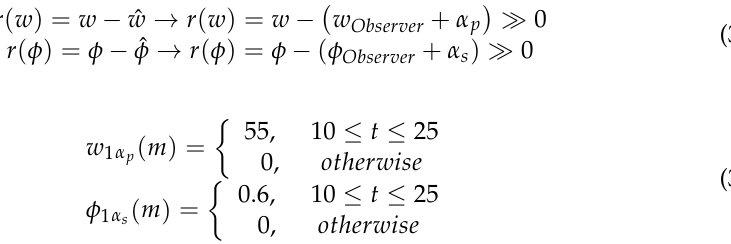
Figure 6. The error between the predicted output and the expected output based on the proposed technique under no-fault condition.